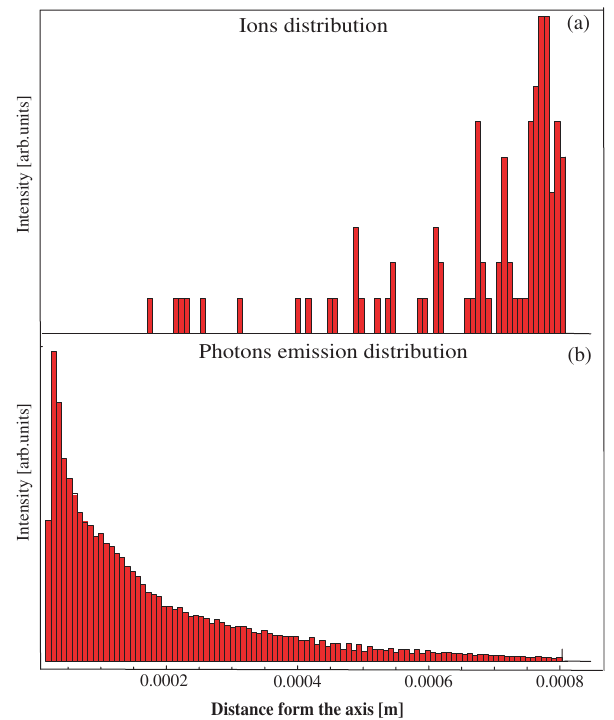
FIG. 2. (Color) Ion drift simulations results. (a) The ions are radially accelerated by four LHC bunches. Their location after 100 ns is displayed. (b) For each ion step a different probability of light emission is taken into account following the decay time. This provides the distribution of the photon